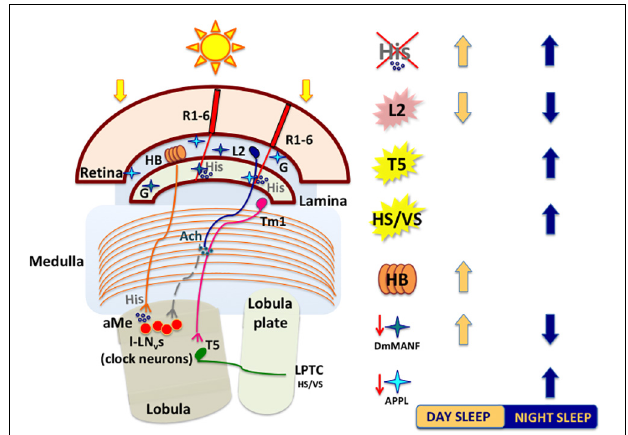
FIGURE 3 | A schematized circuit of neurotransmission regulating sleep centers. Light affects clock neurons (ventral-lateral neurons_LNvs) activity, which stimulates pigment dispersing factor (PDF) release. In turn, PDF inhibits dopamine arousal neurons (DAAs), which normally decrease fan-shaped body (FB) activity through dopamine. Lack of dopamine signalling promotes sleep. PDF activates also Dorsal Neurons posterior (DN1sp), which can inhibit tubercular bulbar cells (TuBu), or activate them through glutamate. Visual stimuli affect Tubu and helicon cells activity, both send signals to the ellipsoid body (EB). EB coordinates FB activity and receives feedback signals from FB through helicon cells, which are inhibited by AstA released from FB. In addition, FB obtains signals from lateral posterior neurons (LPNs) through glutamate. FB processes all inputs and sends final sleep-promoting information through inhibiting GABA signalling to output arousal neurons (OAAs).